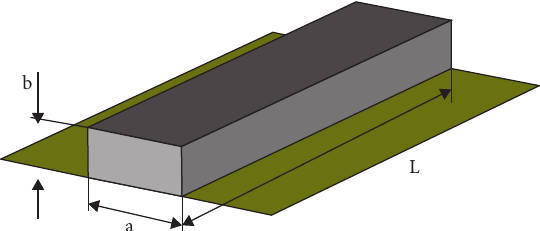
Figure 2: Grounded image guide ( a � 8.8mm, b � 2.54mm, and L � 30mm).